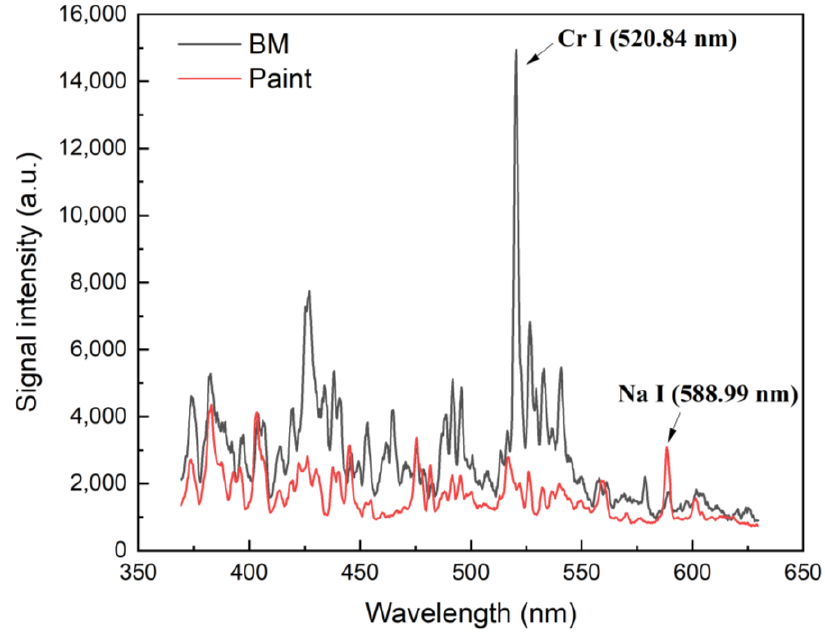
Figure 3. LIBS spectra of the base metal and painted specimen.